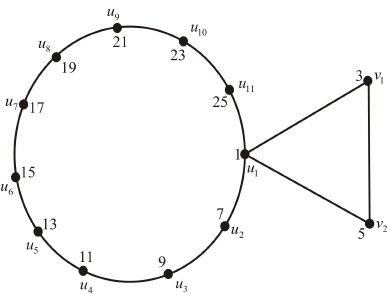
Figure 2: Fish graph C n @ K 3 and its odd prime